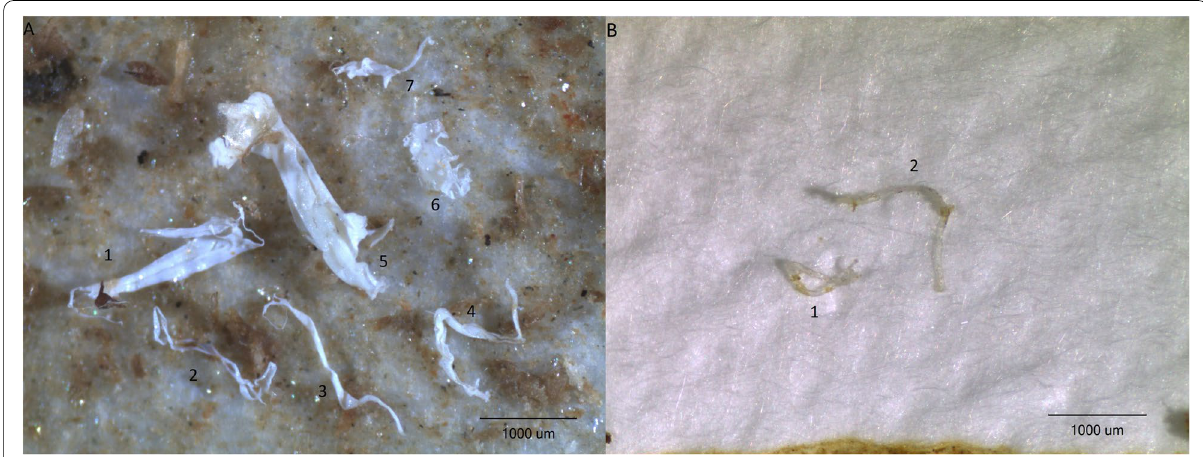
Fig. 2 Examples of A films and B